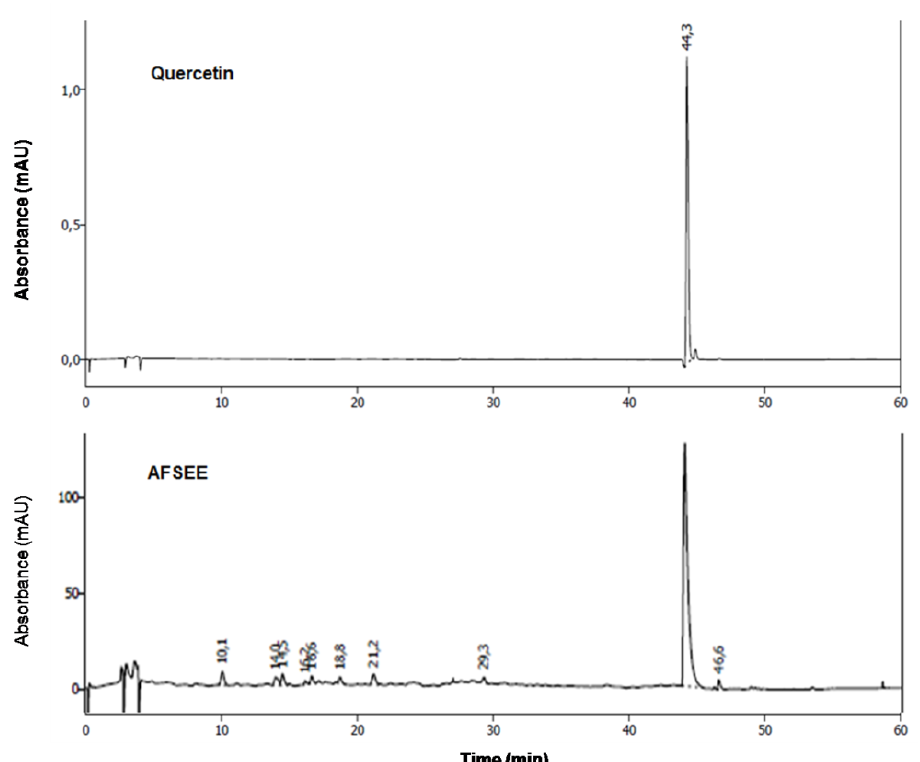
Figure 9. High-performance liquid chromatography (HPLC) fingerprinting of AFSEE: chromatograms of AFSEE and quercetin, AFSEE’s major polyphenol compound, were acquired at 280 nm. HPLC chromatograms of standards used in the analysis are included as supplementary figures.